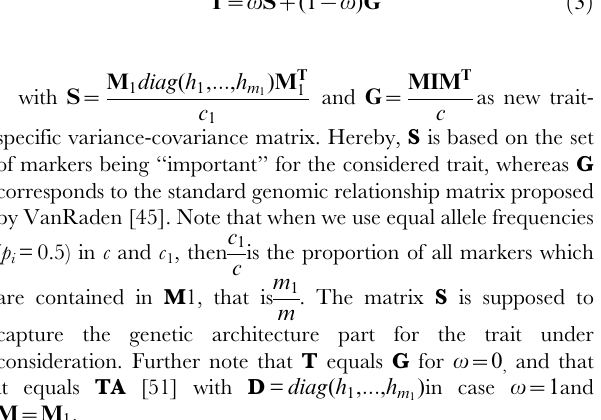
Table 1. Summary statistics of data sets and corresponding